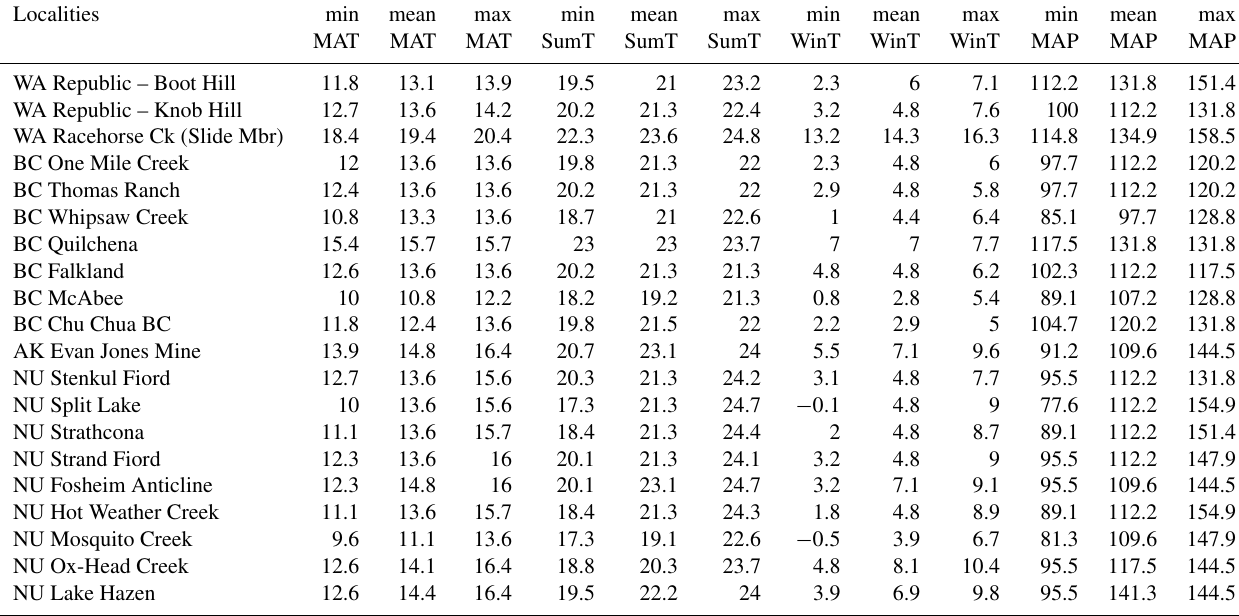
Table A3. Paleoclimate estimates using the NLR-based BA method. BC – British Columbia, Canada; NU – Nunavut, Canada; WA – Wash- ington, USA; AK – Alaska, USA; LS – Landslide.